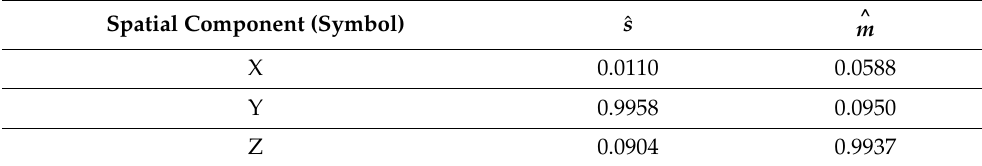
Table 2. The normalized values of sensor properties that were predicted by the optimization algorithm. Spatial Component (Symbol) ˆ s